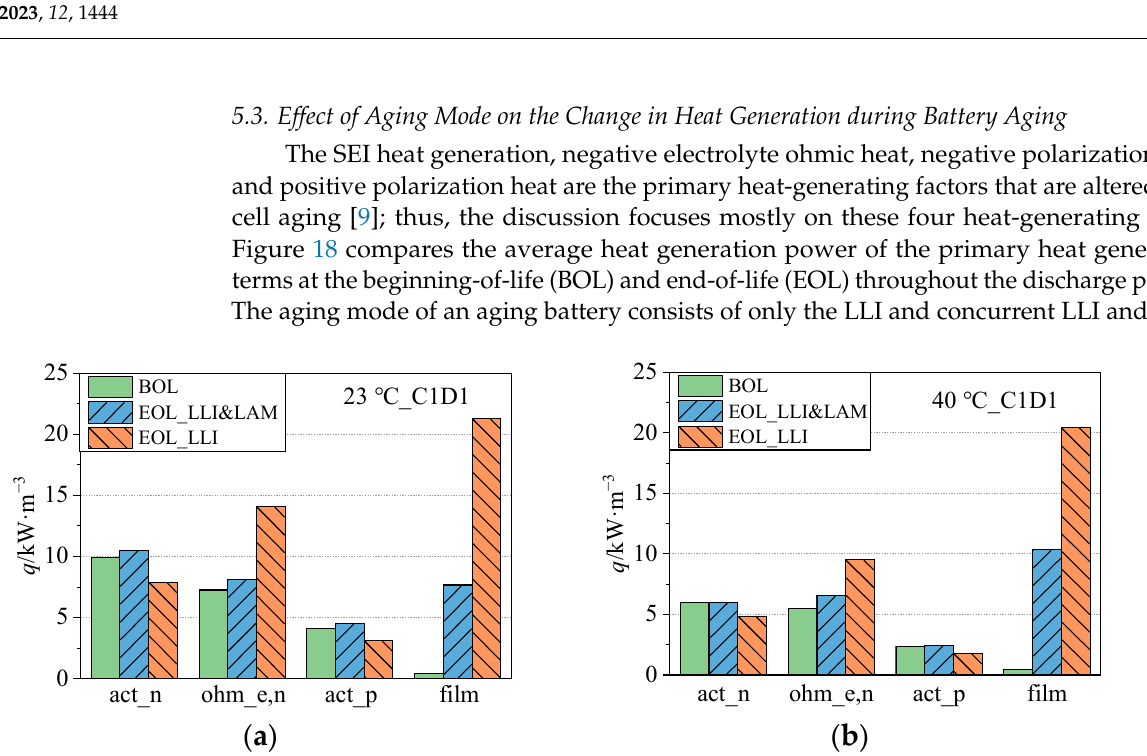
Figure 17. The maximum surface temperature rises during the discharging process of the cell after aging when using different SEI film molar volumes.